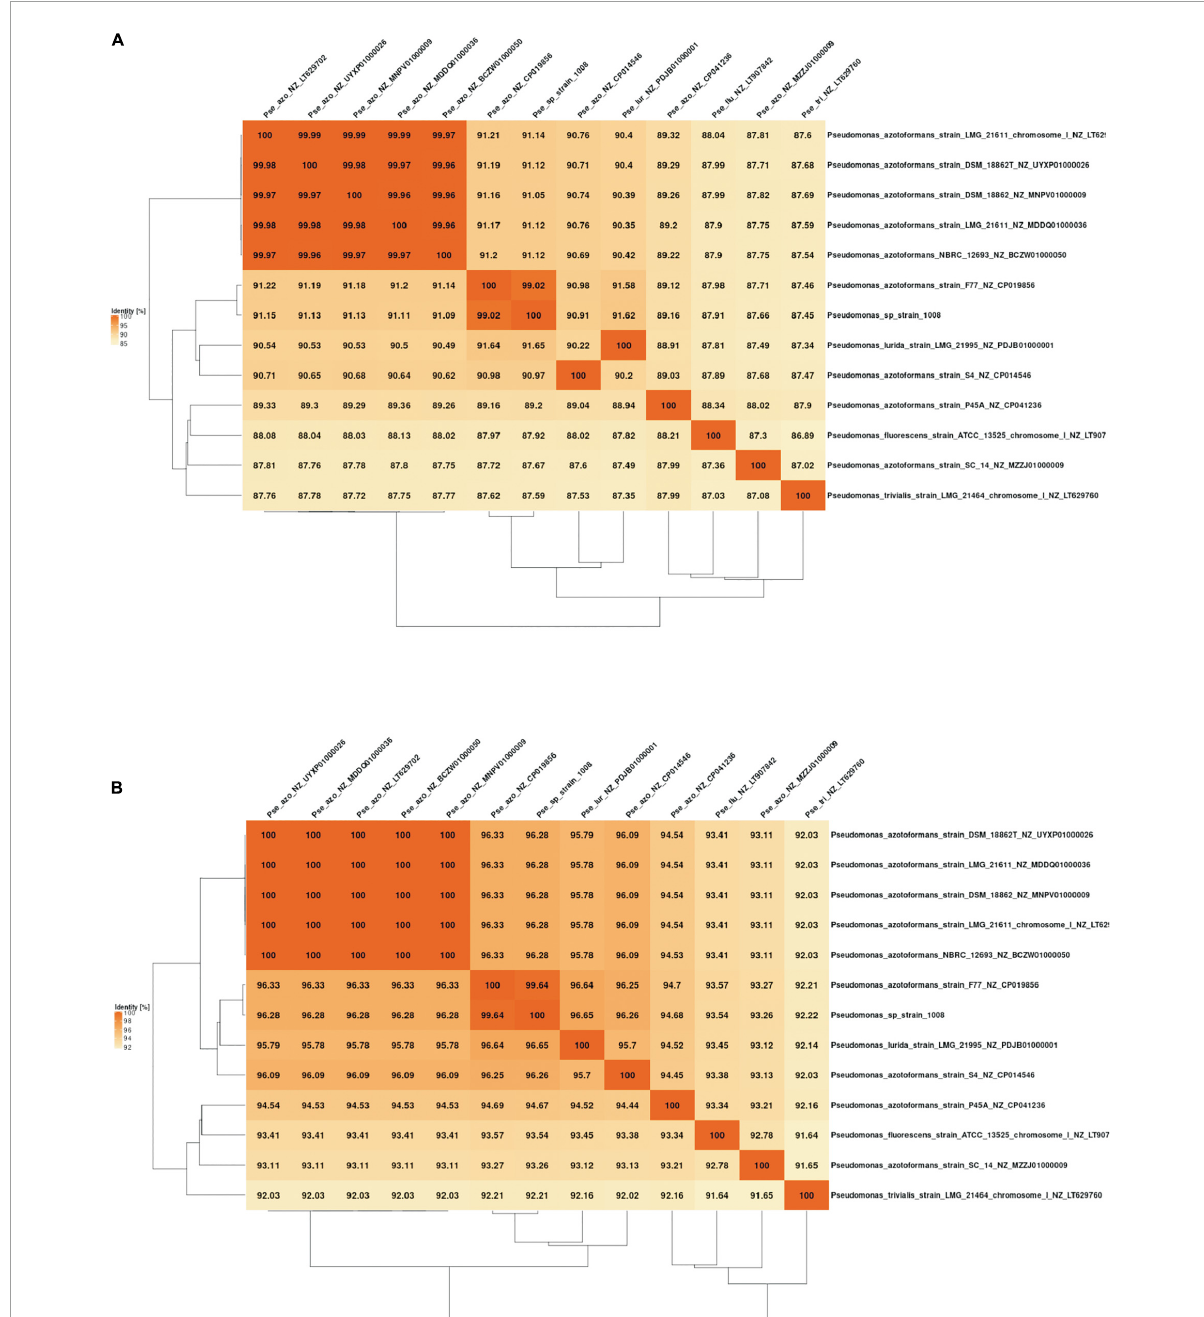
FIGURE5 Overall genome relatedness derived from pairwise genomic comparison between Pseudomonas sp. strain 1008 and type species and isolates with the highest similarity of 16S rDNA sequences. (A) Average nucleotide identity matrix generated with the fastANI matrix tool of the EDGAR platform (https://edgar.computational.bio.uni-giessen.de/cgi-bin/edgar_login.cgi). (B) Average amino acid identity matrix generated with the AAI matrix tool of the EDGAR platform (https://edgar3.computational.bio.uni-giessen.de/cgi-bin/edgar.cgi).